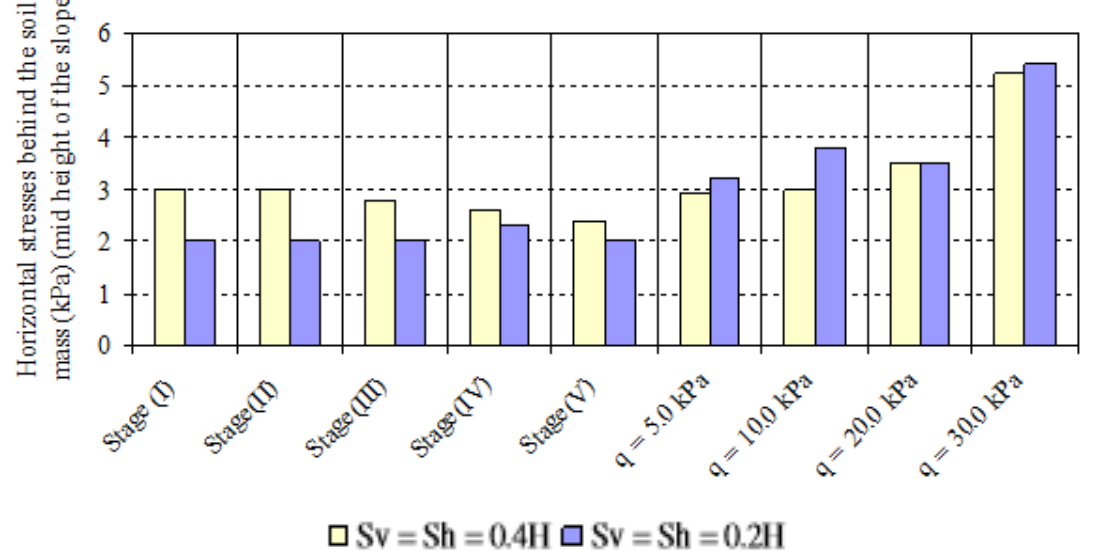
Figure 26. Influence of nail inclination on the slope face vertical stresses at mid height of slope.